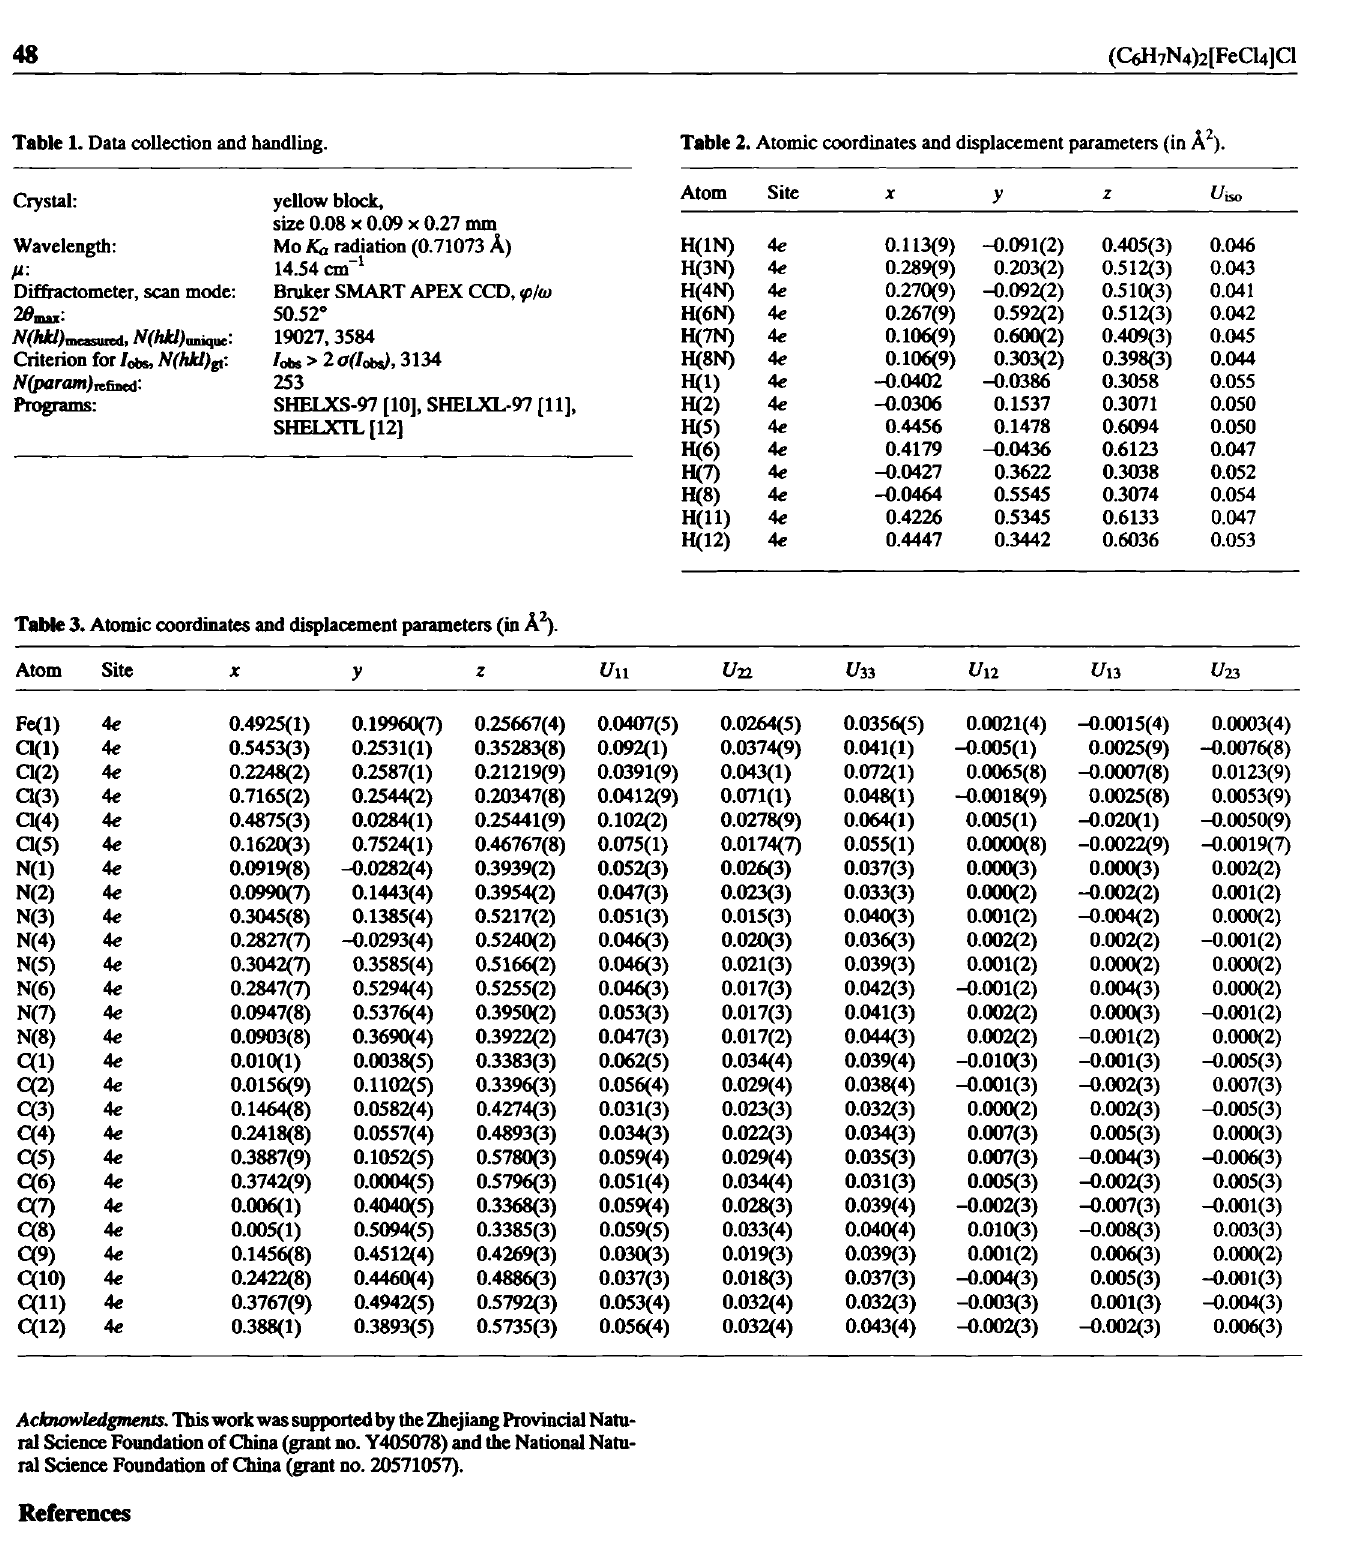
Table 1. Data collection and handling. Table 2. Atomic coordinates and displacement parameters (in A 2 ).